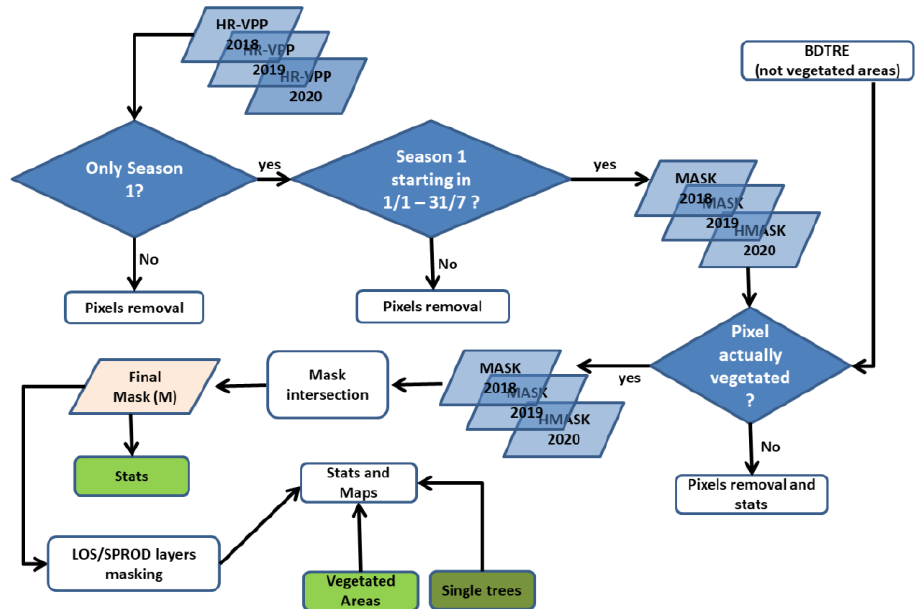
Figure 2. Flowchart showing the operational steps aimed at testing the quality of the selected HR-VPP layers.